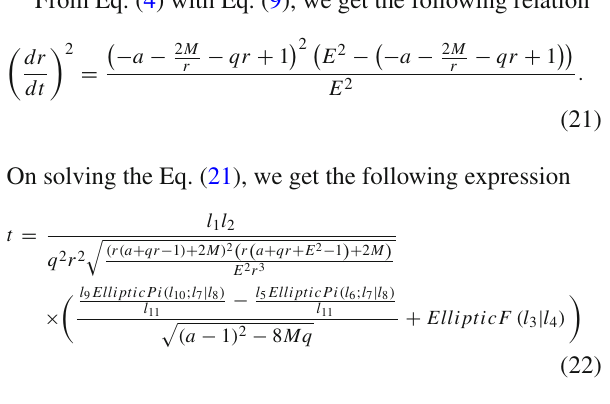
the panel of the second row represents q = 0 . 0010 (blue), q = 0 . 0011 (black), and q = 0 . 0012 (red) with q = 0 . 1. The middle panel of the second row represents q = 0 . 0010 (blue), q = 0 . 0011 (black), and q = 0 . 0012 (red) with q = 0 . 15. The right panel of the second row represents q = 0 . 0010 (blue), q = 0 . 0011 (black), and q = 0 . 0012 (red) with q = 0 .